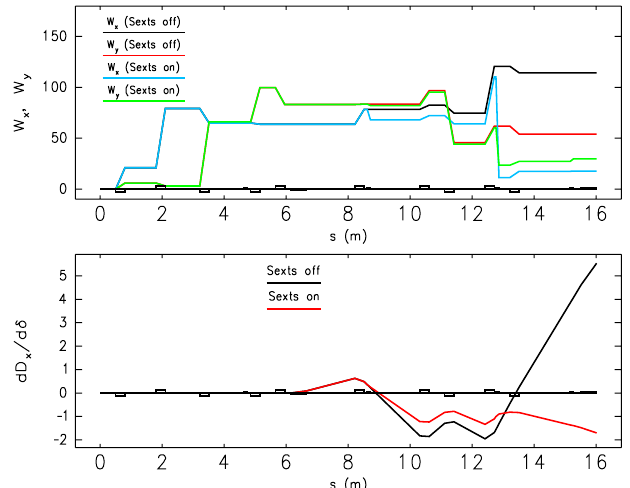
FIG. 7. Top: Chromatic amplitude functions in the arc-to-linac matching achromat before (black, red) and after (blue, green) correction. Bottom: Chromatic derivative of dispersion before (black) and after (red)